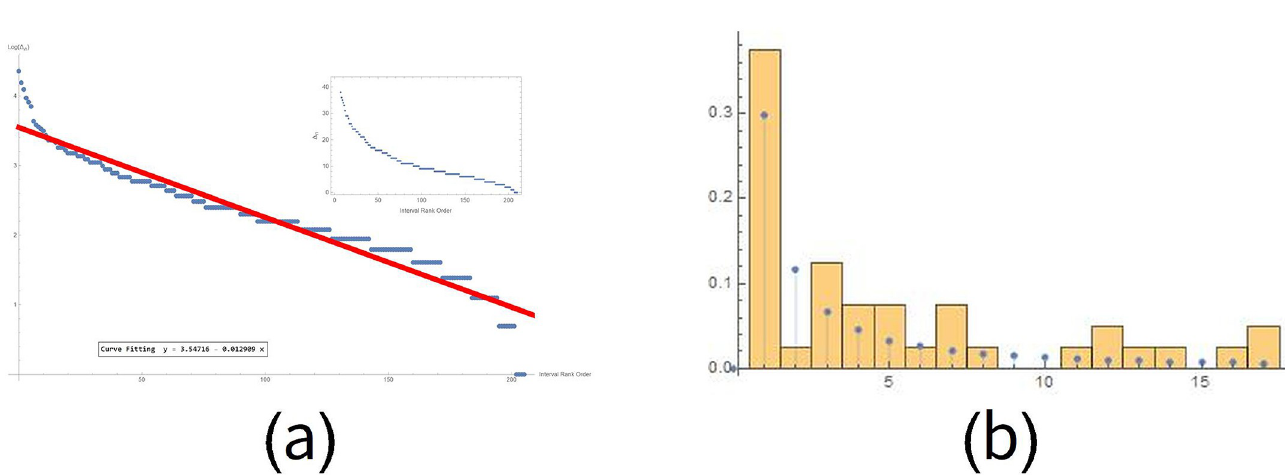
Fig 6. Time differences between the first and the tenth case for the countries. If we order all the intervals i according to Δ i values and number them progressively from 1 to 217, we get the interval rank order, curve fitting 3.548 − 0.013x (a). Furthermore, the figure compares the distribution histograms considering the real data (with full rectangles) and those obtained from a Zipf distribution (with points) (b).